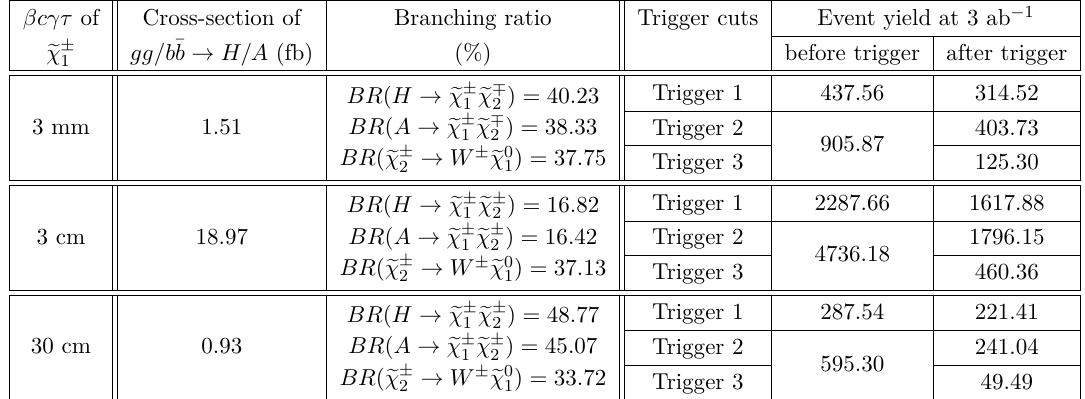
Table 27. Production cross-section and branching ratios for all the three benchmark points along with the yield after putting trigger cuts at 3 ab − 1 . For the leptonic case, the W boson from decayed leptonically ( ‘ = e, µ, τ ), and the W boson decays to jets for the case of jet trigger.